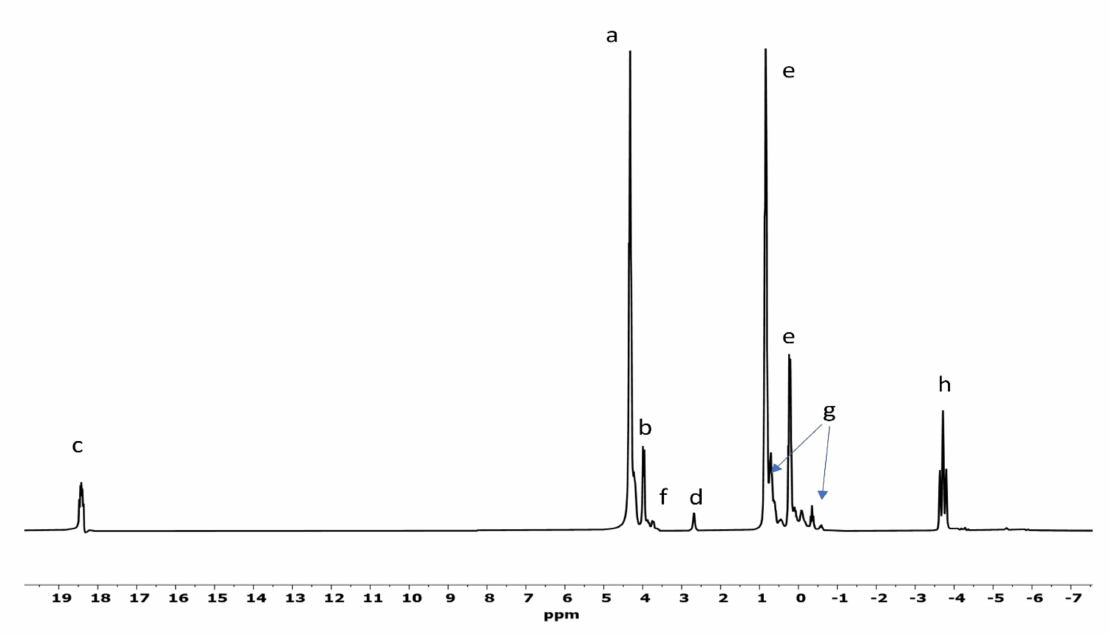
Figure 1. 31 P-NMR of GP formation in the presence of olivine. In addition to all the peaks already discussed. This sample also had some unidentified inorganic phosphate species labeled as peaks ‘h’ and ‘j’.